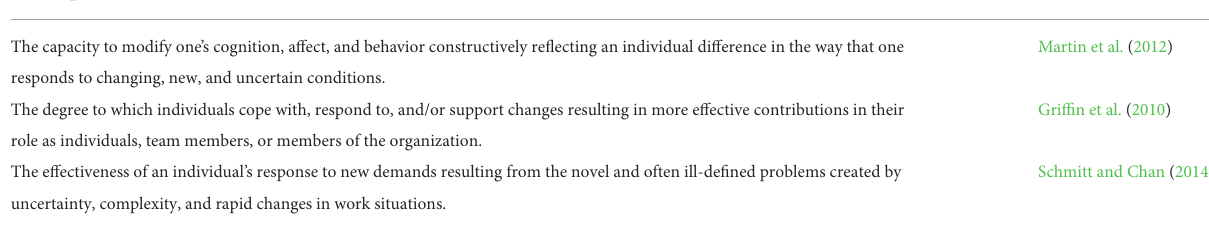
TABLE 6 Conceptualization of adaptive behavior.